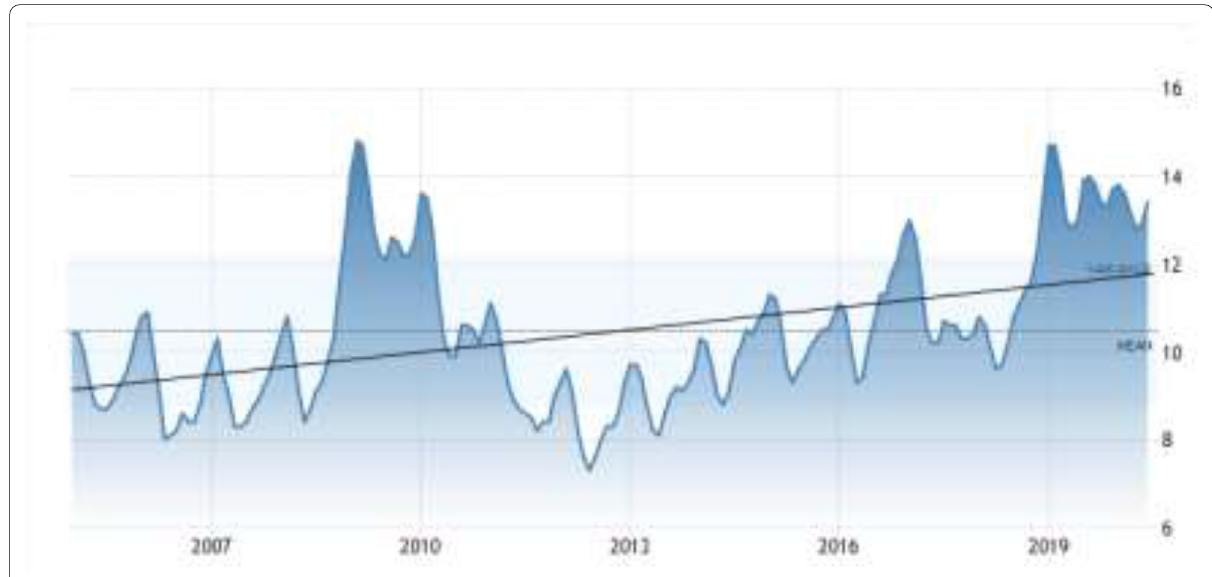
Fig. 1 Changing of the unemployment rate over the years in